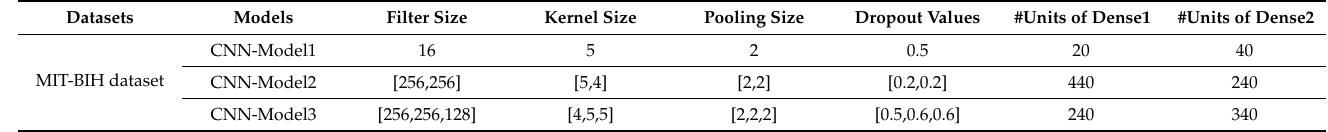
Table 3. Values of the parameters after applying the CNN models to the MIT-BIH